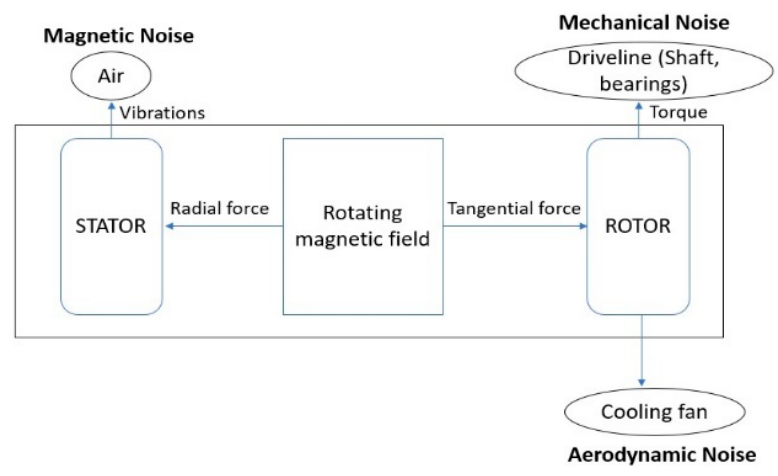
ff erent origins in a rotating electrical Figure 1. Generation of noise of different origins in a rotating electrical machine . Figure 1. Generation of noise of di